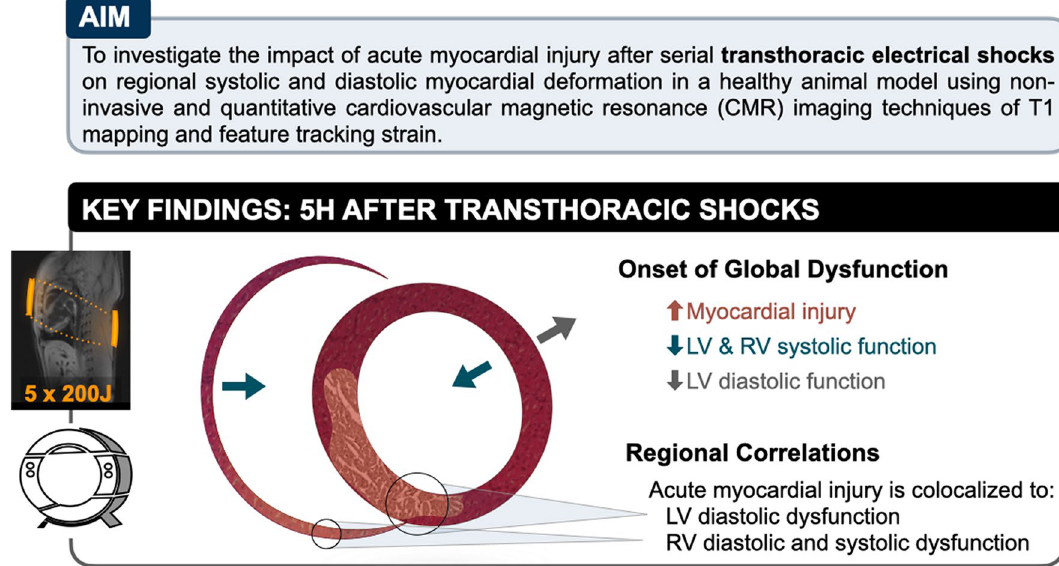
Figure 6. Summary figure. The illustration highlights the aim of the study and the key findings of global and regional systolic and diastolic dysfunction assessed by CMR feature tracking strain techniques, and of myocardial tissue injury quantified non-invasively by CMR T1 mapping and serology and by invasive histological